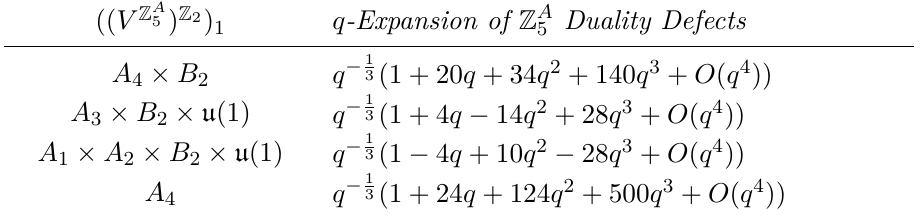
Table 7 . List of the defect partition functions of order 5A, with defect twisting time. The first 3 defects come from the { σ 1 , σ 2 } “flip” conjugacy class lattice action. The final defect lifts from the { τ, σ 1 σ 2 τ } “exchange” conjugacy class lattice